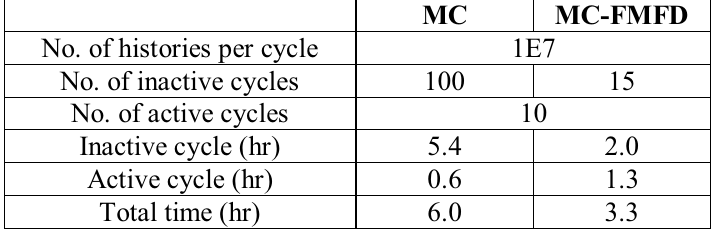
Table III. Comparison of the computing